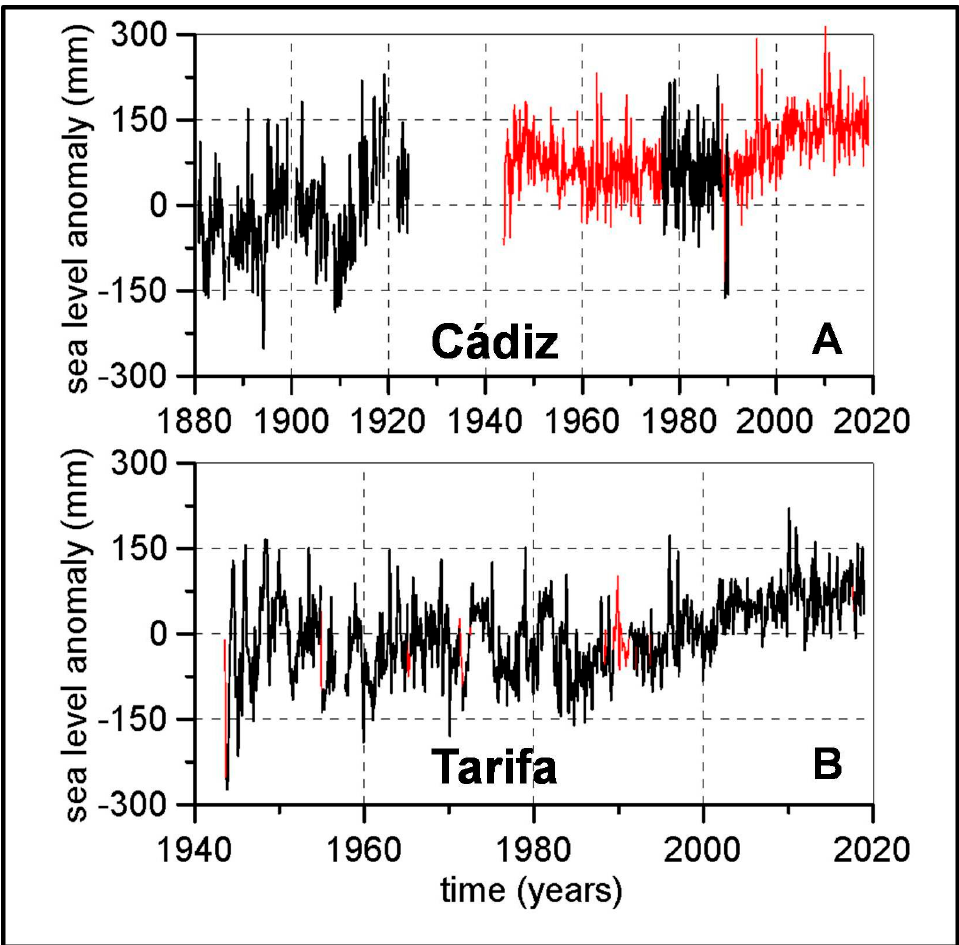
Figure 3. Observed and reconstructed sea level anomalies for Cádiz and Tarifa. Black lines in ( A , B ) are the time series of anomalies (observed minus seasonal cycle) at Cádiz and Tarifa. Red lines are the time series of anomalies of sea level where gaps have been filled using nearby stations.